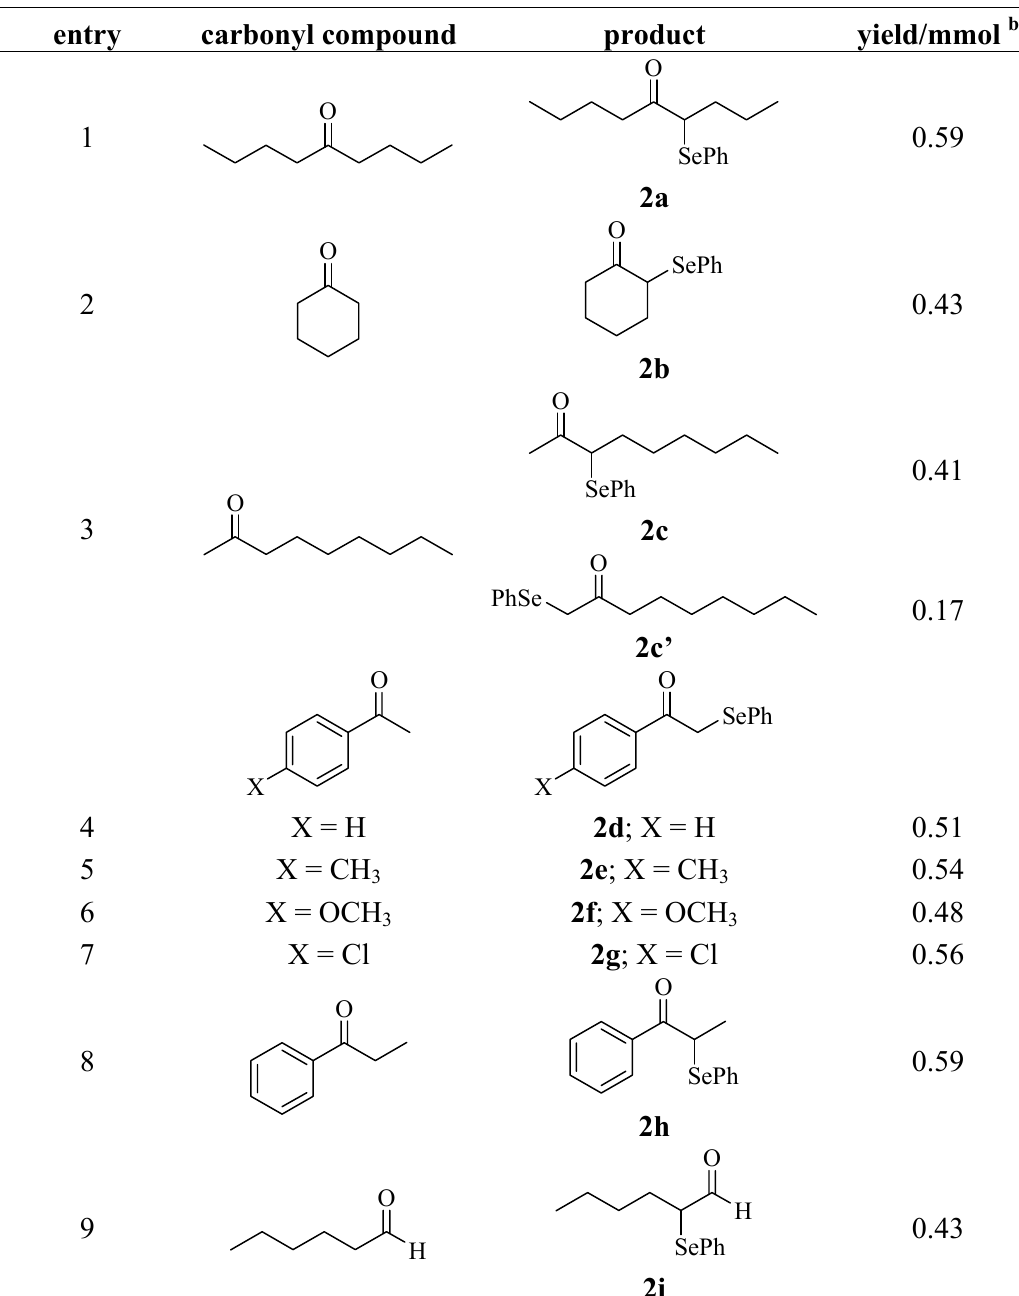
Table 2. Cesium carbonate-catalyzed α -phenylselenation of carbonyl compounds with diphenyl diselenides.